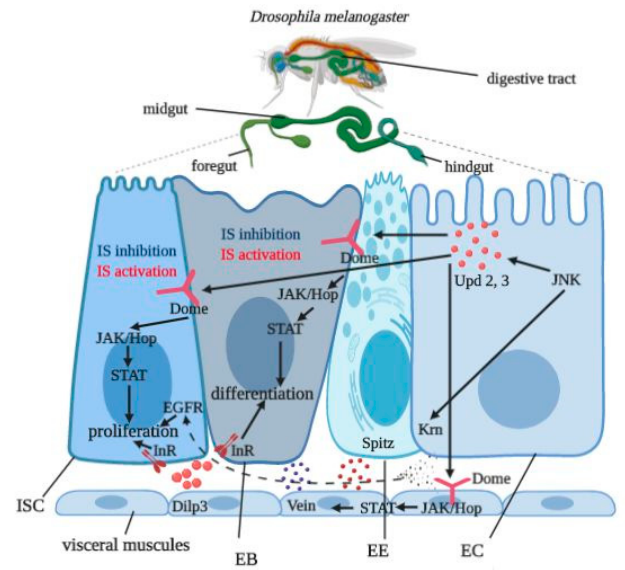
Figure 6. The digestive tract of Drosophila melanogaster and niche intestinal stem cell (ISC) of midgut epithelium. IIS was manipulated in ISCs and EBs in the Drosophila midgut, and regulated ISC proliferation and EB differentiation. ECs produce signaling ligands Upd2 and Upd3 for JAK–STAT activation in ISCs, EBs, and visceral muscles. JAK–STAT in visceral muscles activates Vein secretion, which together with Spitz and Keren may bind EGFR in ISCs. JAK–STAT, EGFR, and local IIS regulate ISC proliferation and EB differentiation.